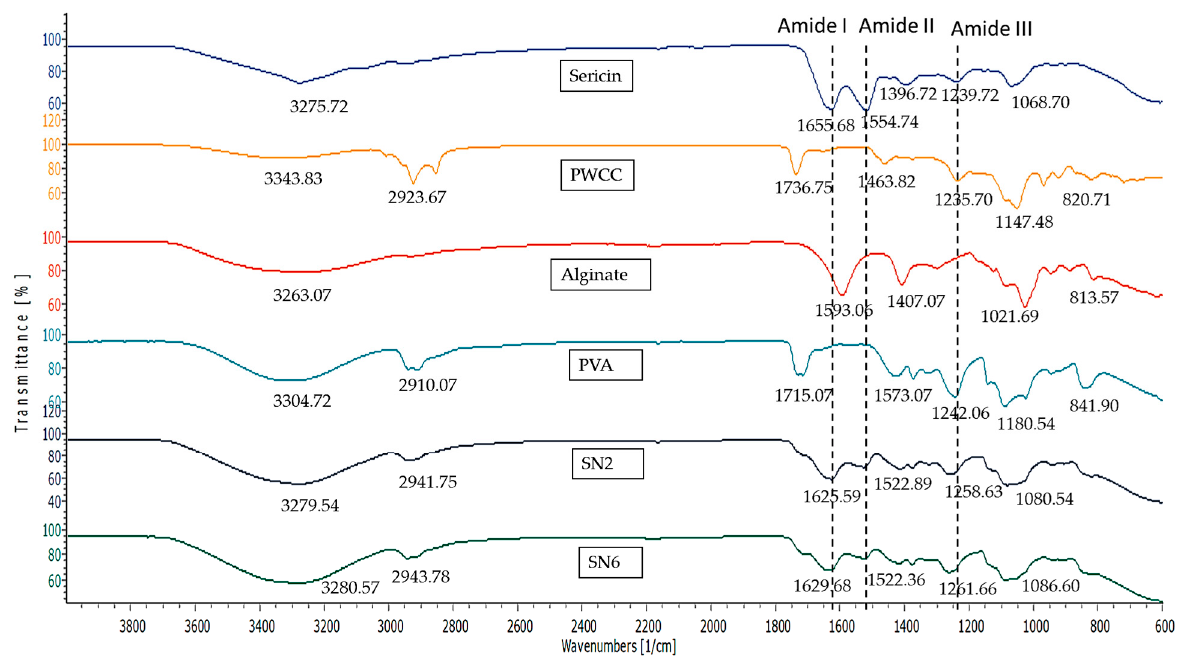
Figure 9. Infrared spectra of Sericin, Alginate, PWCSS, and formulations SN2 and SN6. Purple waxy corn cob extract (PWCC) showed peaks of anthocyanin at 3343.83,